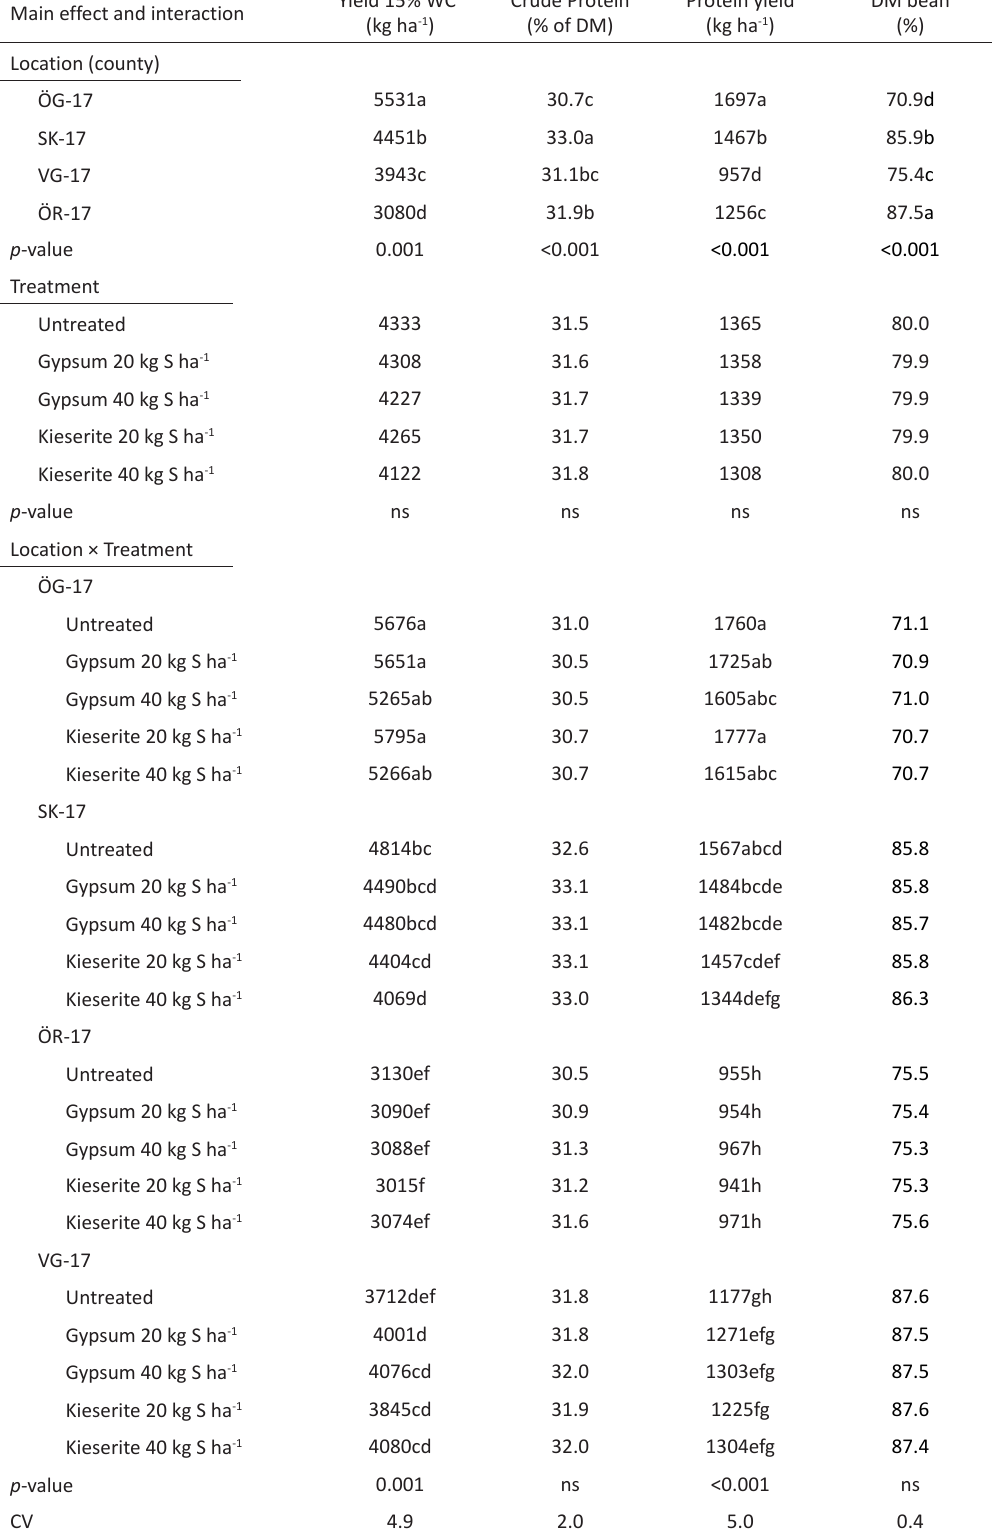
Table 6. Content of crude protein; protein yield and dry matter content (DM) of faba bean supplied with various sulphur fertilizer applications in 2017 Main effect and